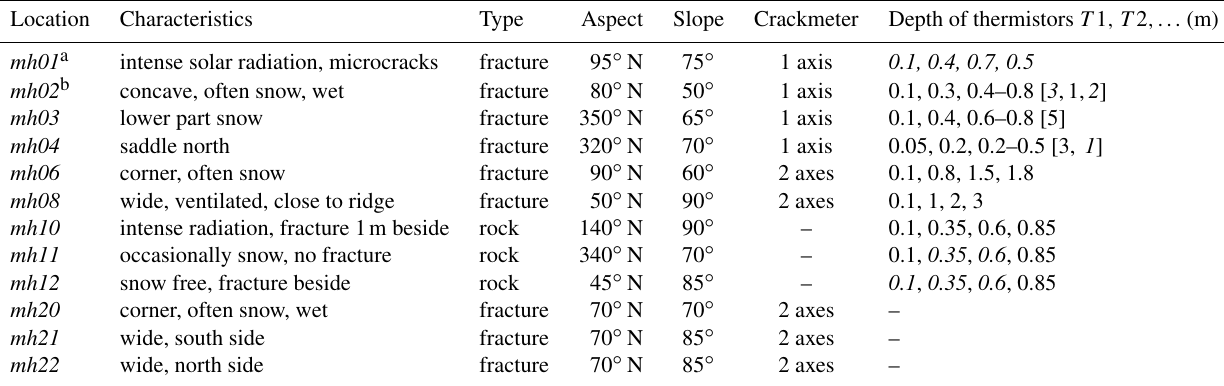
Table 1. Metadata for all measurement locations, providing characteristics, type, orientation and instrumentation. If type is “fracture”, thermistors are installed in fracture. Otherwise the thermistors are drilled in rock.